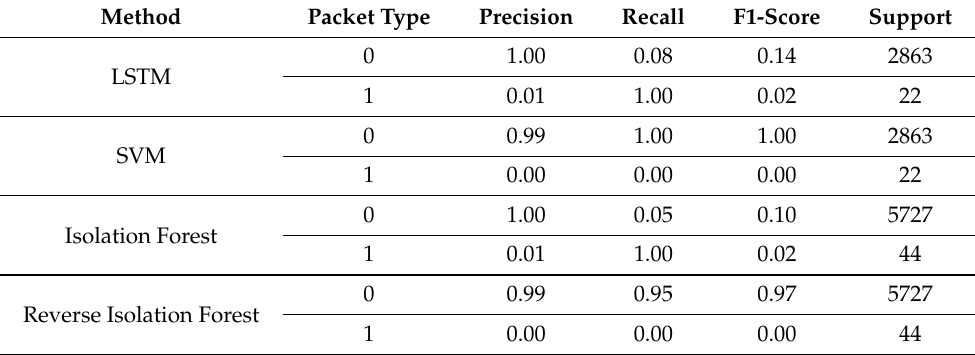
Table 3. The models’ metrics after validation for a single day from the ASNM-CDX-2009 dataset.